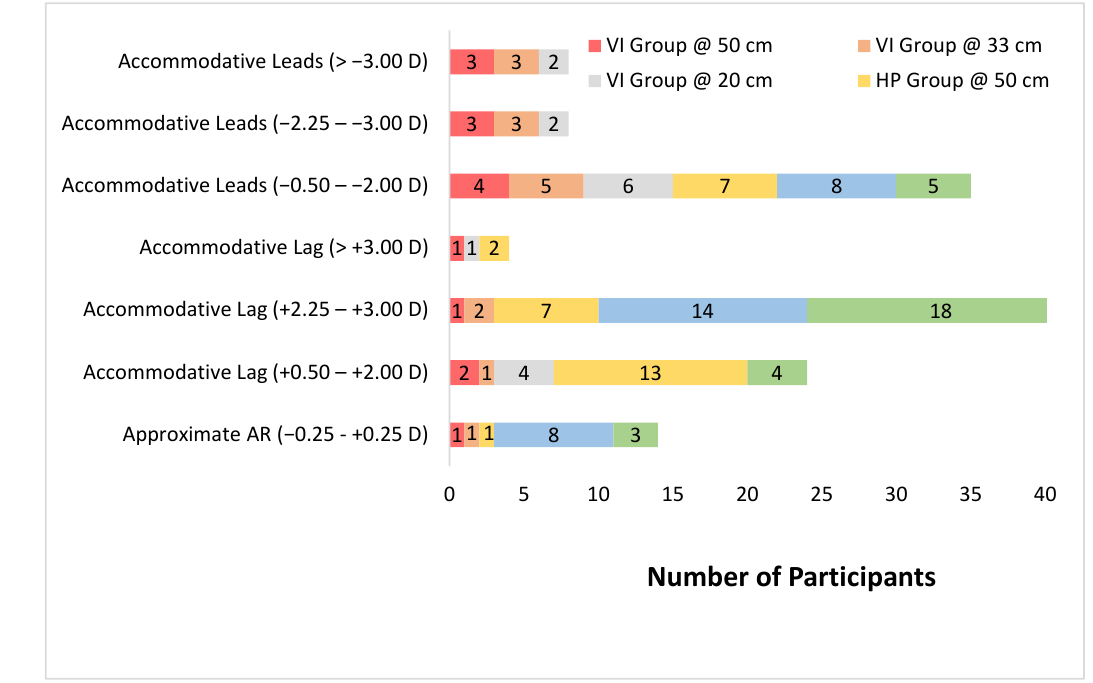
Figure 2. Frequencies of the accommodative responses of control participants and visual impairments participants under the three conditions: 50, 33 and 20 CM.